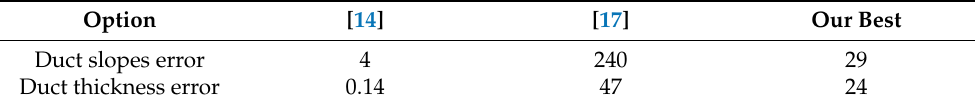
Figure 8. Comparison of the estimated and real atmospheric refractivity. ( a ) Using the measured data of Case 2; ( b ) using the measured data of Case 3; ( c ) using the measured data of Case 4; ( d ) using the measured data of Case 5. Table 3. Comparison